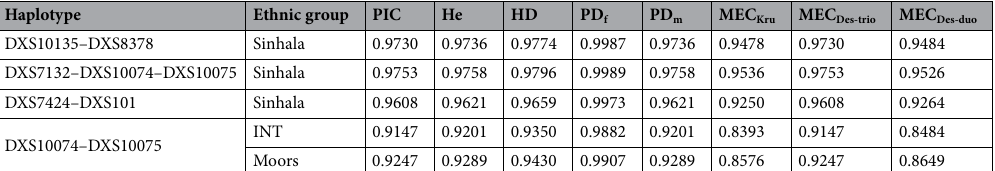
Table 5. Forensic statistical parameters of the four haplotypes. PIC polymorphism information content, He expected heterozygosity, HD haplotype diversity, PD f power of discrimination in females, PD m power of discrimination in males, MEC Kru mean exclusion chance Kruger, MEC Des-trio mean exclusion chance Desmaris trio, MEC Des-duo mean exclusion chance Desmaris duo, INT Indian